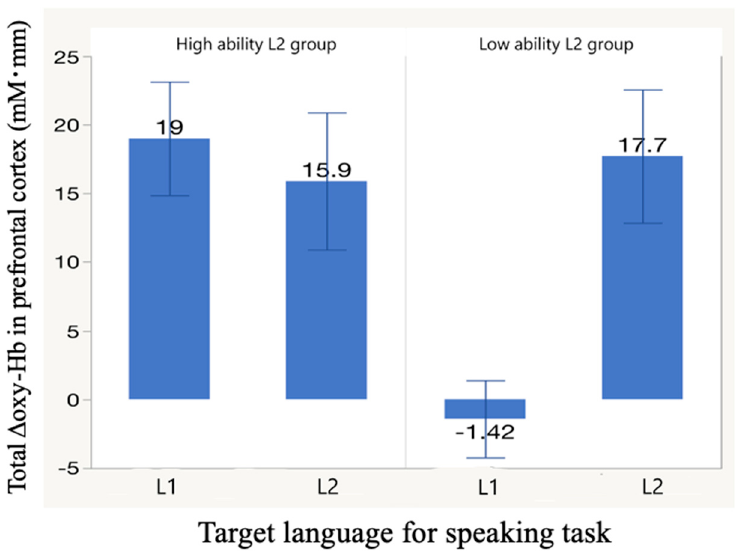
Figure 5. Approximate integral values of blood flow change ( ∆ oxy-Hb) in the prefrontal cortex during speaking tasks.